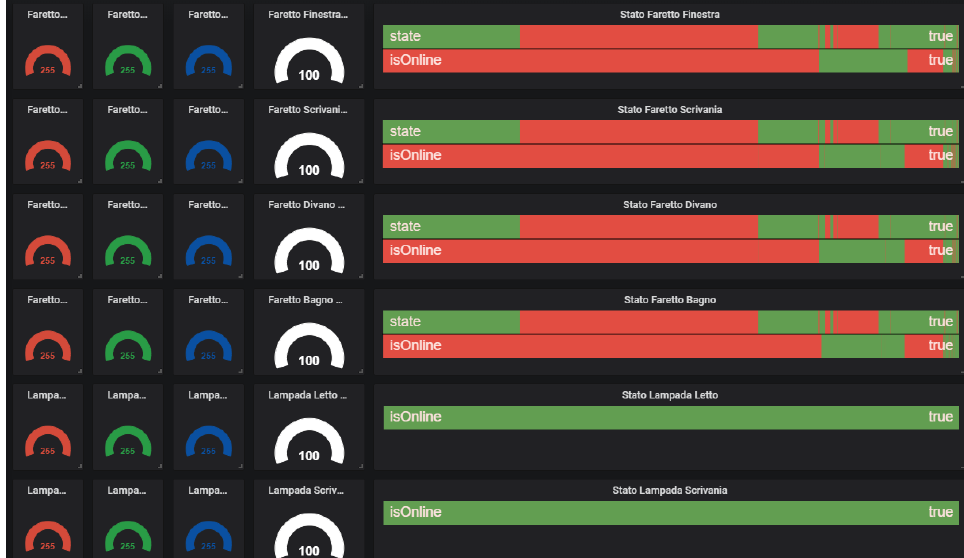
Figure 5. A set of dashboard views reporting the sensed cabin parameters.